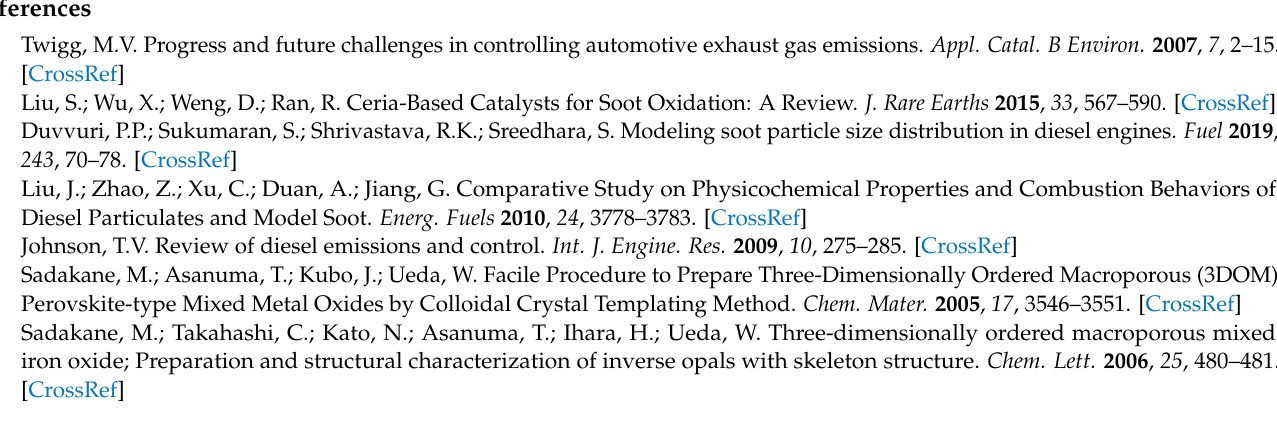
Figure S4: In-situ Raman spectra of MnCo 2 O 4 -HC (a,d and g), Mn 0.9 K 0.1 Co 2 O 4 -HC (b,e and h) and Mn0.7K0.3Co2O4-HC (c,f and i) monolith catalysts under laser wavelength of 532 nm for